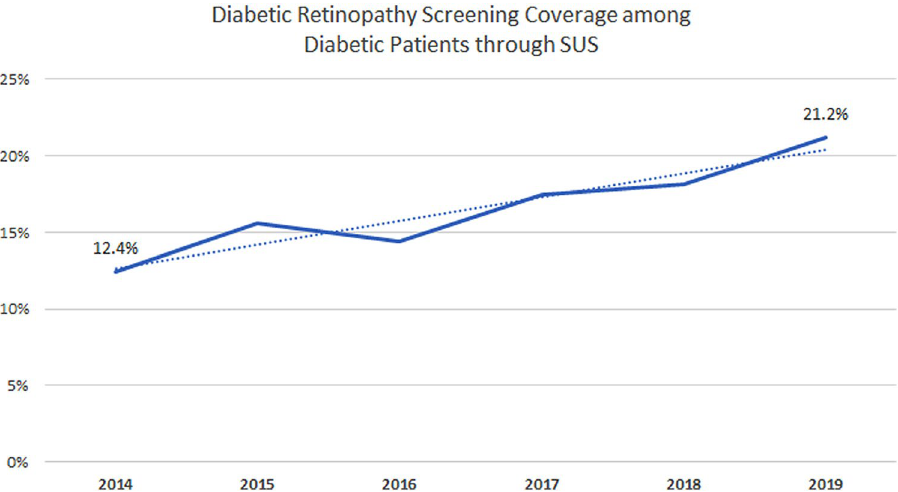
Figure 1. Diabetic retinopathy screening coverage among diabetic patients through SUS from 2014 to